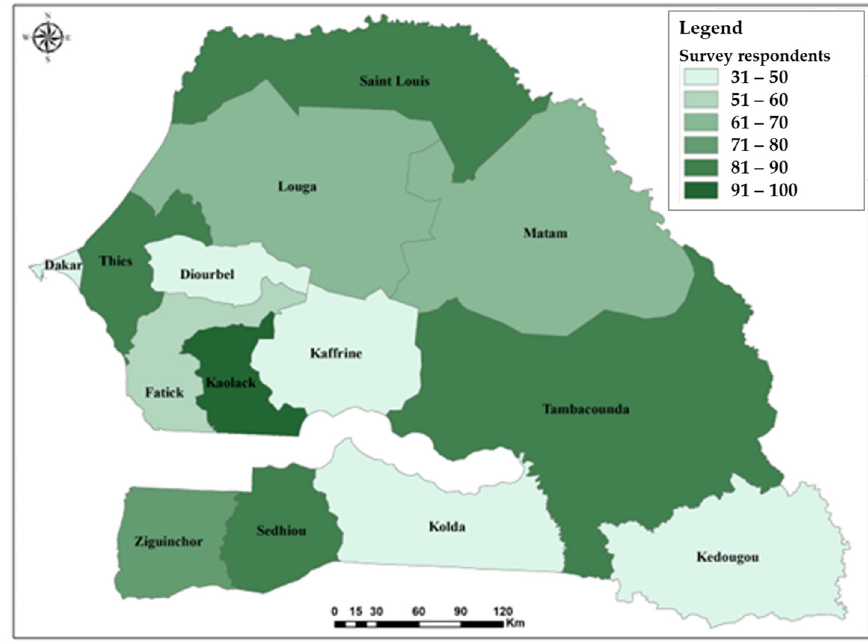
Figure 1. Administrative regions in Senegal and number of survey respondents in each region.